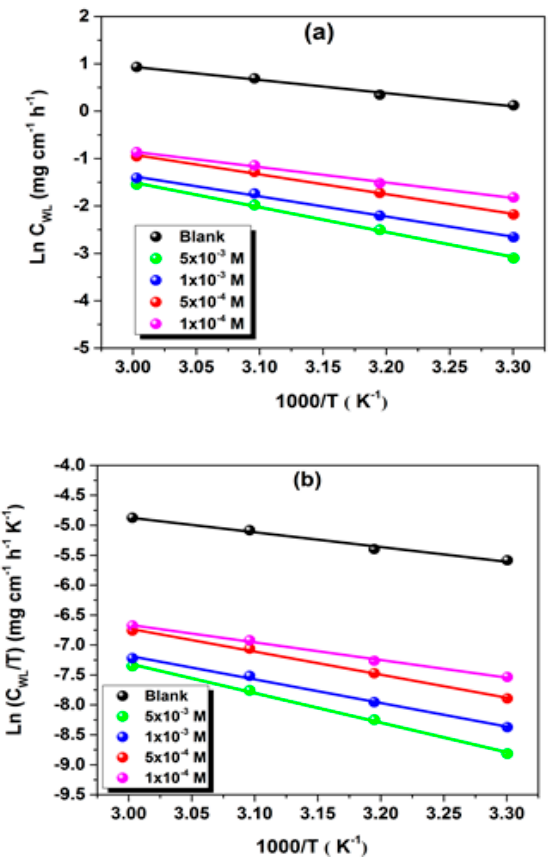
Figure 2. Arrhenius ( a ) and transition state ( b ) plots for corrosion inhibition of mild steel in the absence and presence of different concentrations of MPH in 1.0 M HCl.